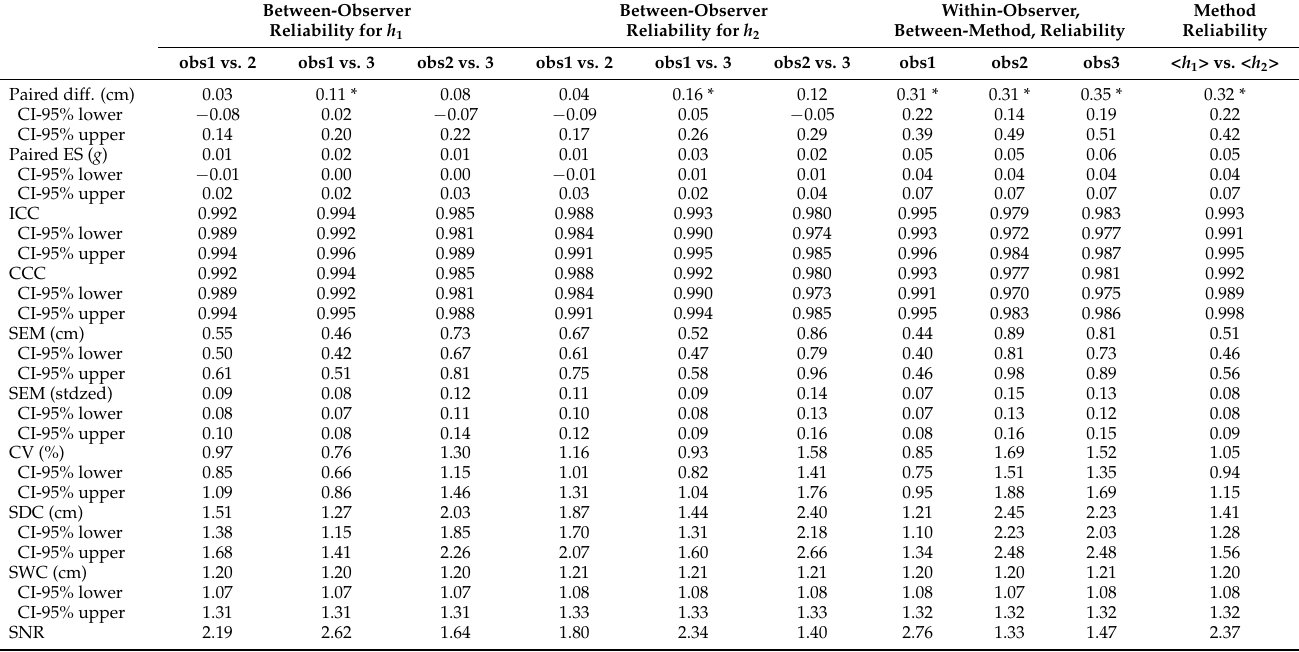
Table 1. Between-, within-observer, and method reliability of jump heights derived with My Jump 2 for two observation